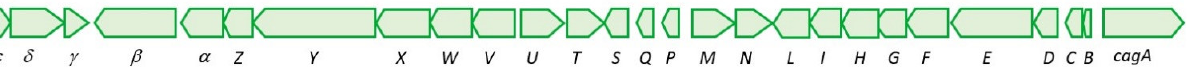
Figure 1. Schematic representation of cag PAI . The genetic arrangement of the 28 genes from the cag PAI of the reference strain H. pylori 26695 is depicted based on the organization proposed by Phuc et al., 2021 [26].